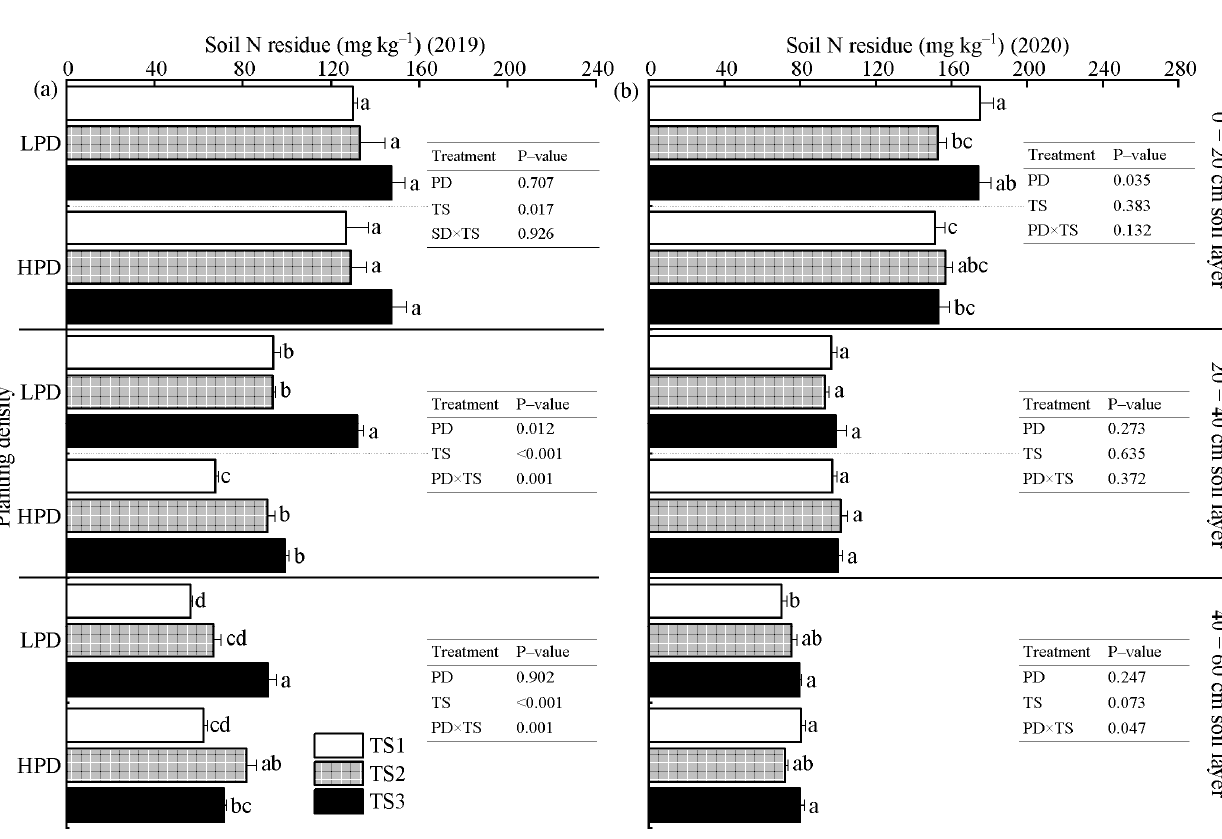
Figure 7. Effects of planting density and method of tillage and sowing on ( a , b ) soil N residue in different soil layers in the 2019 and 2020 seasons. Data are presented as means ± standard errors, and the bars above the columns are standard errors. The different letters on the bars indicate significant differences at the 0.05 probability level. PD and TS are planting density and the method of tillage and sowing. The data in the tables are p values.